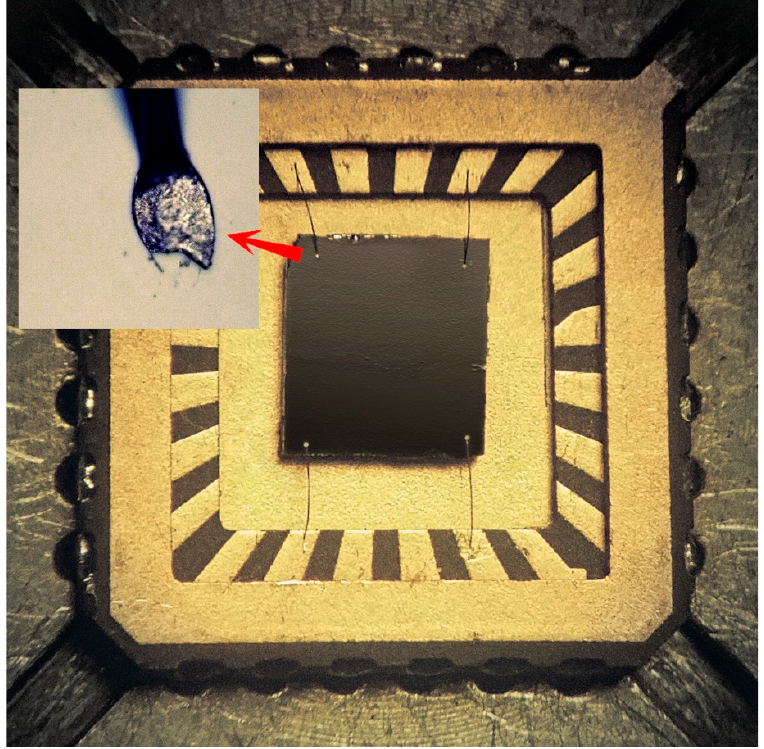
Figure 1. Image of 5 × 5 mm sample mounted in the sample holder. Al/Si wires are attached by bonding.